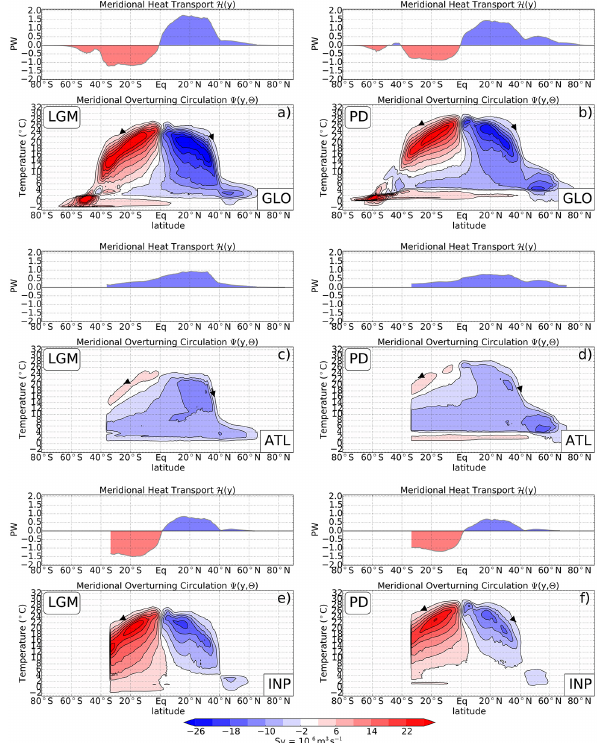
Figure 4. LGM and PD meridional overturning circulation in lati- tude–temperature coordinates for (a, b) the Global Ocean, (c, d) the Atlantic basin, and (e, f) the Indo-Pacific basin. The contour inter- val for the circulation is 4Sv. The blue cells correspond to clock- wise circulations whereas the red cells are for counter-clockwise motions. For each basin, the oceanic meridional heat transport in PW is